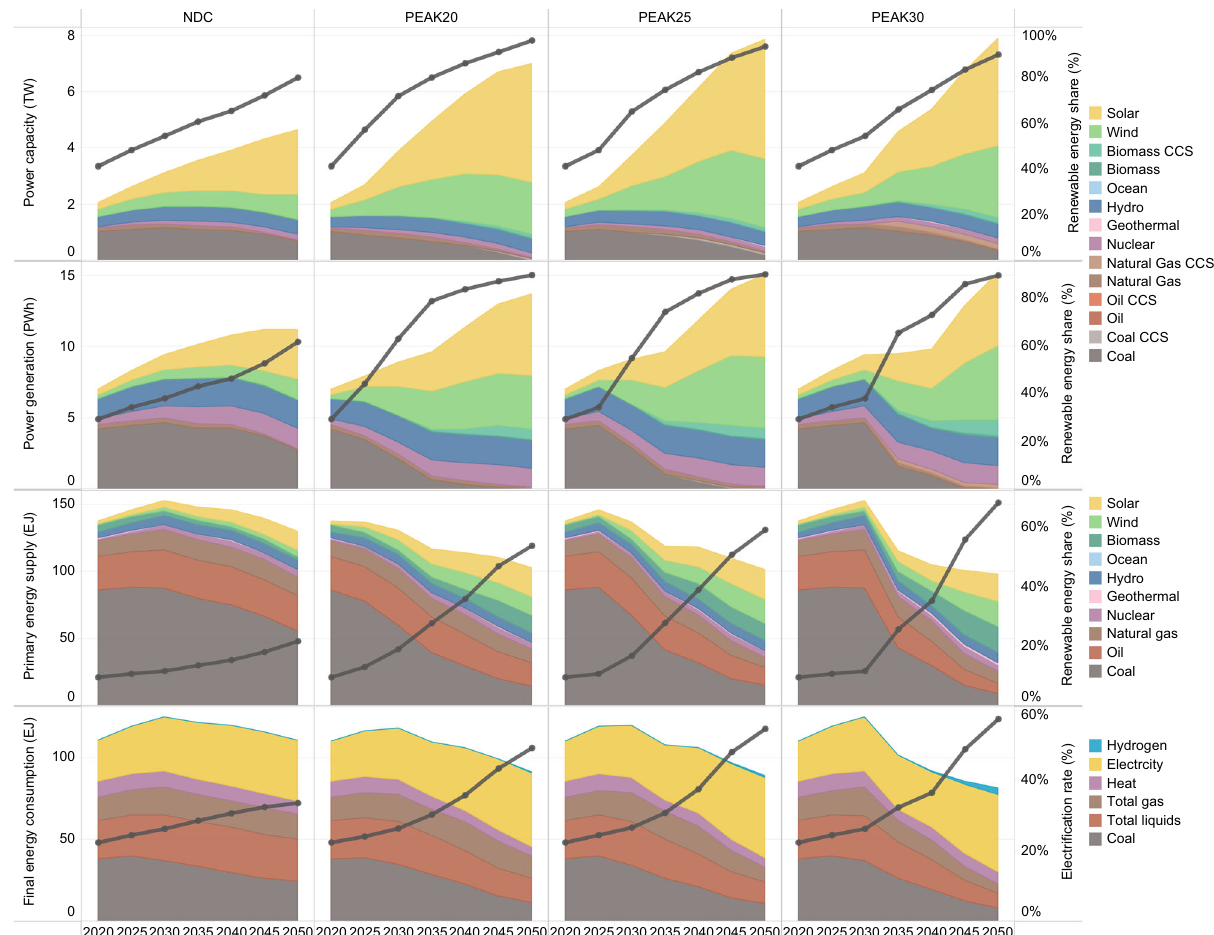
Fig. 3 Graphic of the power installed capacity (unit: TW), the power generation (unit: PWh), the primary energy mix (unit: EJ), and the fi nal energy mix (unit: EJ) for the intermediate case in each scenario. For the power installed capacity, the stacked area chart shows different power plant types, and the black line represents the proportion of the renewable energy contribution to the total capacity. For the power generation, the stacked area chart shows the annual power generation of different types of power generation technologies. The black line represents the proportion of renewable energy power generation to the total power generation. In the legend, the fuel names ending in CCS indicate power plants equipped with CCS, and otherwise indicate power plants without CCS. For the primary energy mix, the stacked area chart represents different types of primary energy supply, and the black line represents the renewable energy share. The calori fi c value calculation method is applied for primary energy statistics. For the fi nal energy mix, the stacked area chart shows the end-use of different energy types, and the black line represents the electri fi cation